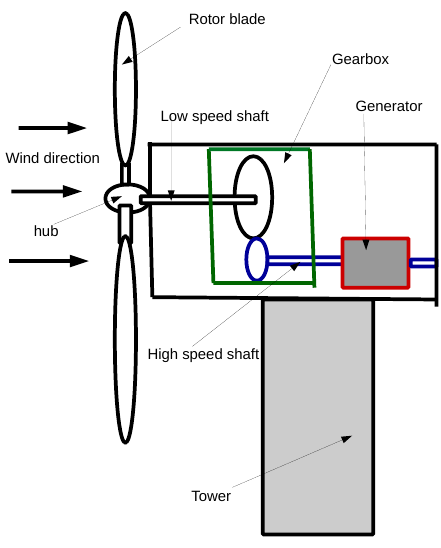
Figure 1. Single-mesh gearbox structure.